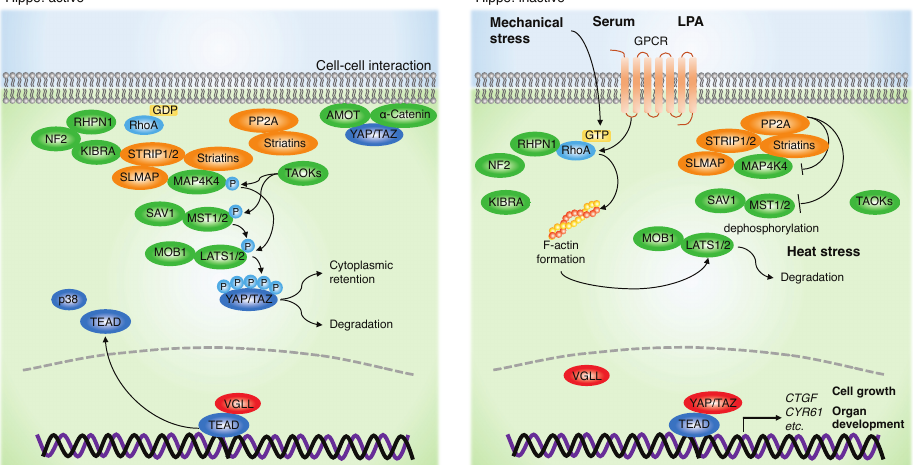
Figure 1. Roles of the Hippo pathway and YAP/TAZ. TAOKs phosphorylate MAP4Ks and MST1/2. Activated MAP4Ks and MST1/2 phosphorylate LATS1/2. Activated LATS1/2 phosphorylates YAP/TAZ at multiple serine residues, leading to its cytoplasmic retention or degradation. Cell-cell interaction induces cytoplasmic sequestration of YAP/TAZ by AMOT and α -catenin. While the Hippo is inactive, dephosphorylated YAP/TAZ translocates to the nucleus, binds to TEAD, and enhances transcription of growth-related genes. Mechanical stress induces RhoA activation and F- actin formation, thereby inhibiting LATS1/2. Serum or LPA treatment inhibits MAP4K4 and MST1/2 through STRIPAK formation, which causes LATS1/2 inactivation. Heat stress induces LATS1/2 dephosphorylation and degradation. Abbreviations are: ras homolog family member A (RhoA), Rho GTPase binding protein 1 (RHPN1), Neurofibromin 2 (NF2; also known as Merlin), kidney and brain protein (KIBRA; also known as WWC1), STRN-interacting protein (STRIP1/2), sarcolemmal membrane-associated protein (SLMAP), the angiomotin (AMOT) family, Mitogen-activated protein kinase kinase kinase kinase 4 (MAP4K4), TAO kinases (TAOKs), mammalian STE20-like kinase 1 and 2 (MST1/2; MST2 is also known as STK3), salvador homolog 1 (SAV1), large tumor suppressor 1 and 2 (LATS1/2), MOB kinase activator 1A and 1B (MOB1A/B), Yes-associated protein (YAP), and transcriptional co-activator with PDZ binding motif (TAZ; also known as WWTR1), ras homolog family member A (RhoA), vestigial-like proteins (VGLL), TEA domain family members (TEAD), connective growth factor ( CTGF ), and cysteine-rich angiogenic inducer 61 ( CYR61 ), lysophosphatidic acid (LPA), and G protein-coupled receptor